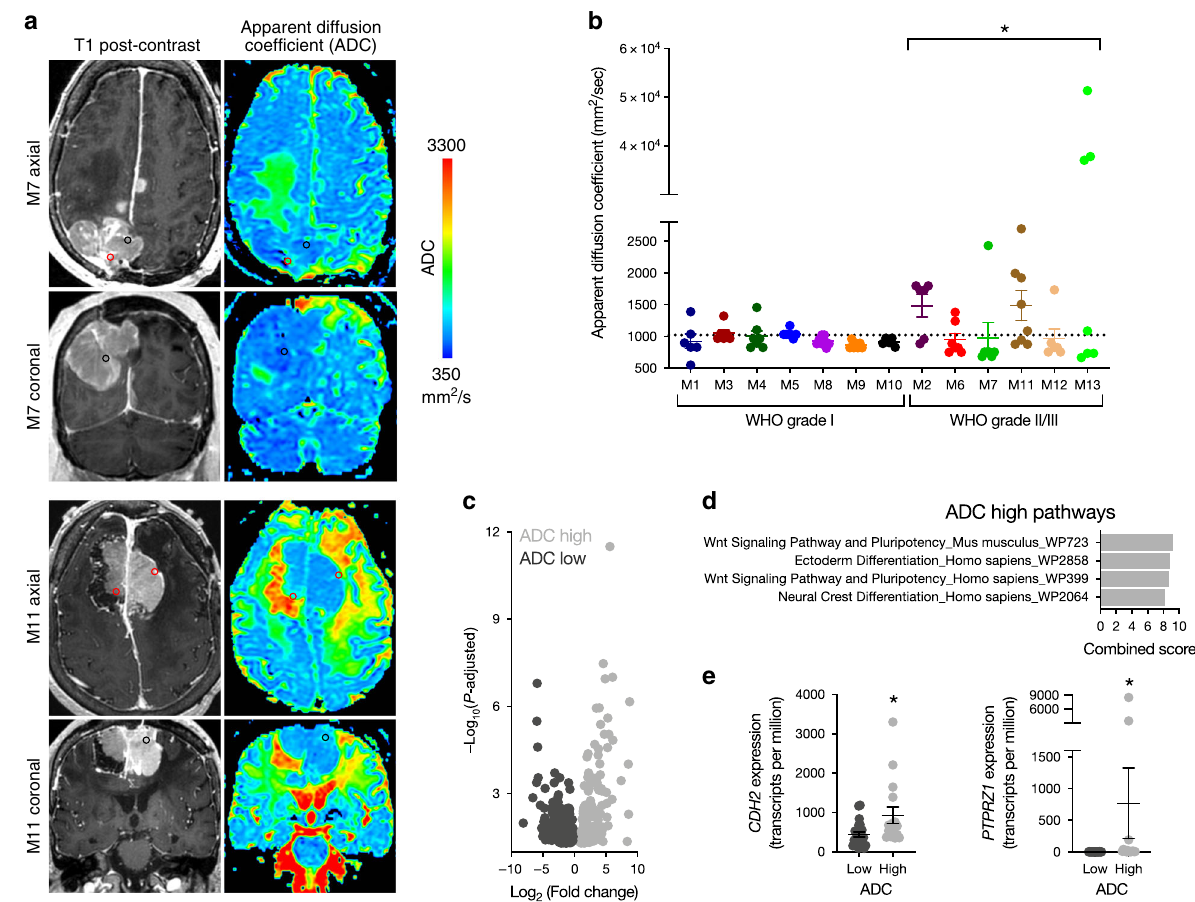
Fig. 3 Elevated MR ADC distinguishes developmental gene expression programs in high grade meningioma. a Preoperative T1 post-contrast and apparent diffusion coef fi cient (ADC) magnetic resonance imaging of spatially distinct regions within meningiomas M7 and M11 demonstrate signi fi cant radiologic heterogeneity in high grade meningioma. Black and red circles indicate ADC low and high sample locations, respectively. b WHO grades II and III meningiomas have greater heterogeneity of ADC values than WHO grade I meningiomas. * denotes statistical signi fi cance between aggregate ADC values from WHO grade I and WHO grades II and III meningiomas, the latter of which were pooled for analysis. c RNA sequencing reveals 452 differentially expressed genes between ADC low and ADC high regions in WHO grades II and III meningiomas. d , e Gene ontology analysis from RNA sequencing demonstrates that regions with high ADC values in WHO grade II and grade III meningiomas are enriched in Wnt pathway and neuronal development genes, such as CDH2 and PTPRZ1 . * P ≤ 0.05, two-tailed Student ’ s unpaired t test. Mean± standard error of the mean (as shown by error bars) are denoted for plots in ( b , e ). Samples from spatially distinct meningioma samples are color-coordinated by